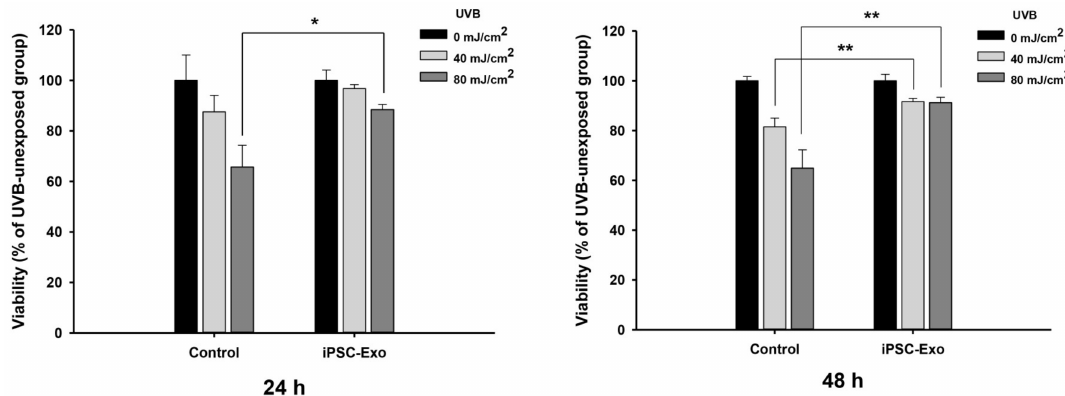
Figure 4. Protective effect of iPSC-Exo on UVB-induced cell damage. HDFs were treated with 20 × 10 8 particles/mL iPSC-Exo for 24 h in serum-free DMEM/F12 and simultaneously irradiated with UVB (315 nm). After further incubation for the indicated time interval in serum-containing growth medium, the populations of viable cells were determined by MTT assay. * p < 0.05, ** p < 0.01 compared to the UVB-irradiated and iPSC-Exo-untreated group. Error bars indicate standard deviations of triplicate samples in a single representative